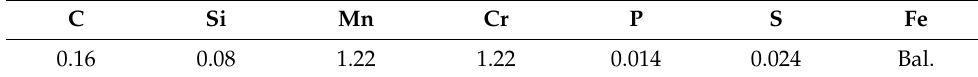
Table 1. Chemical composition of the experimental steel